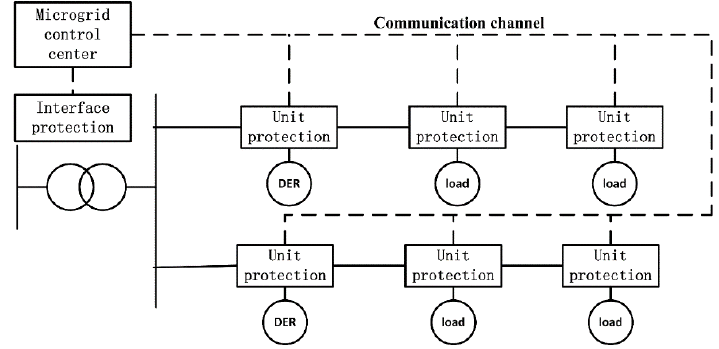
Figure 6. Microgrid protection system configuration. DER, distributed energy resources.